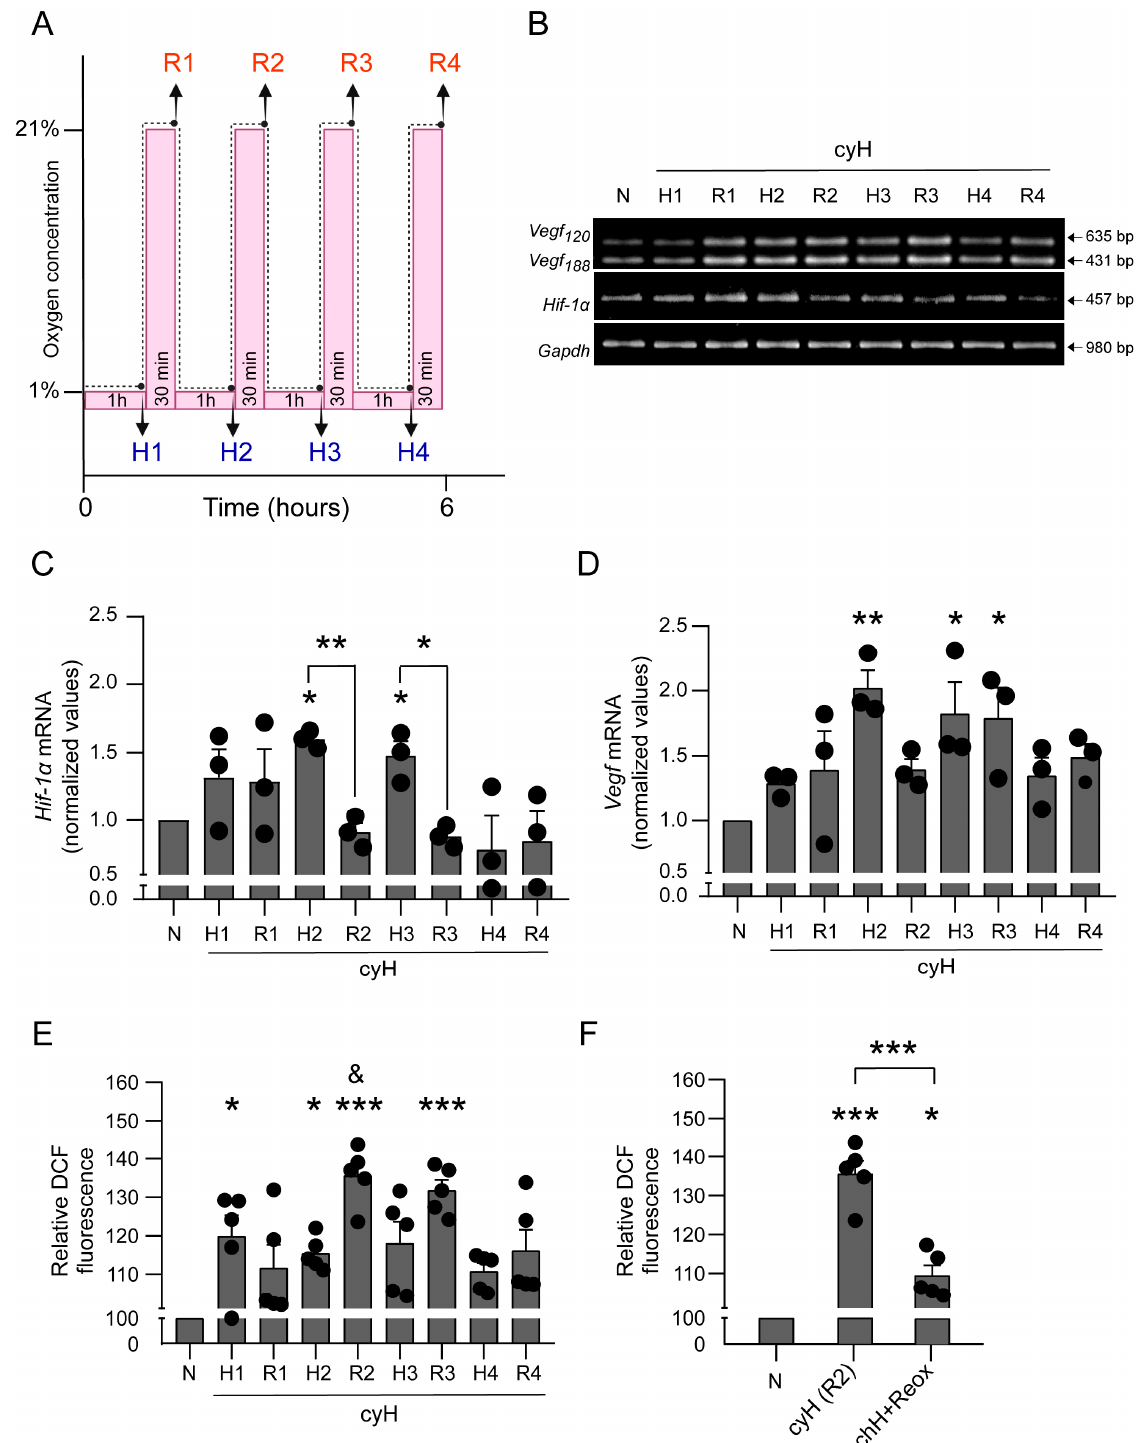
4. Discussion Figure 2. Cyclic hypoxia increases Hif-1 α and Vegf mRNA levels and promotes ROS production in early re-oxygenation periods in BMMCs. ( A ) Experimental protocol of cyH indicating the time and the hypoxia/re-oxygenation cycles to which BMMCs were exposed. Arrows indicate the exact point where cells were harvested. The total time of the protocol (hypoxic + re-oxygenation periods) was accomplished in 6 h. ( B ) Two million BMMCs were incubated in normoxia (6 h at 21%O 2 , N) or cyH according to the protocol described in A. Total mRNA was purified at indicated points for RT-PCR analysis of Hif-1 α and Vegf expression. A representative image from three distinct experiments performed with independent cultures of BMMCs is shown. ( C ) Densitometric quantification of Hif-1